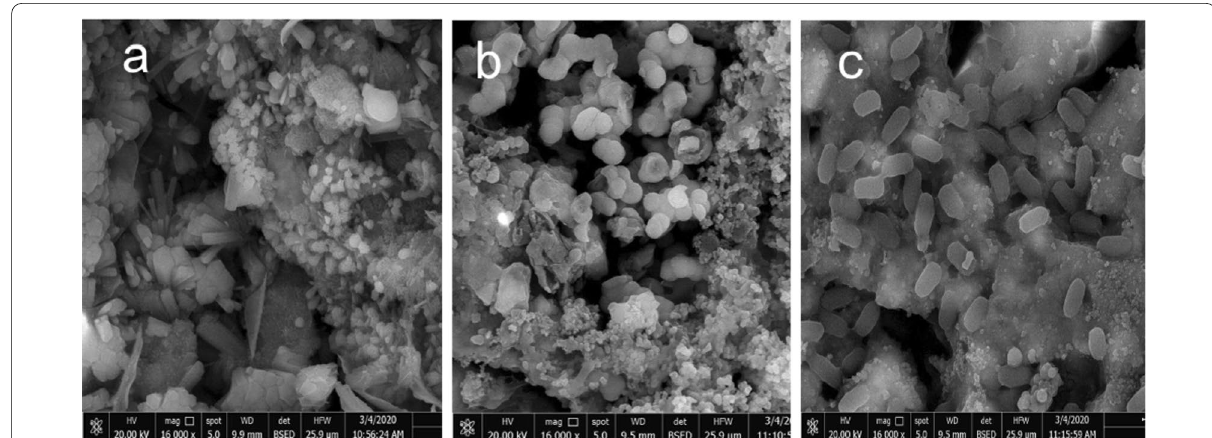
Fig. 11 SEM micrographs of 14-day sample cured in distilled water (DW plate a ), simulated body fluid (SBF, plate b ) and Pseudomonas aeruginosa in Mueller Hinton Broth (plate c )